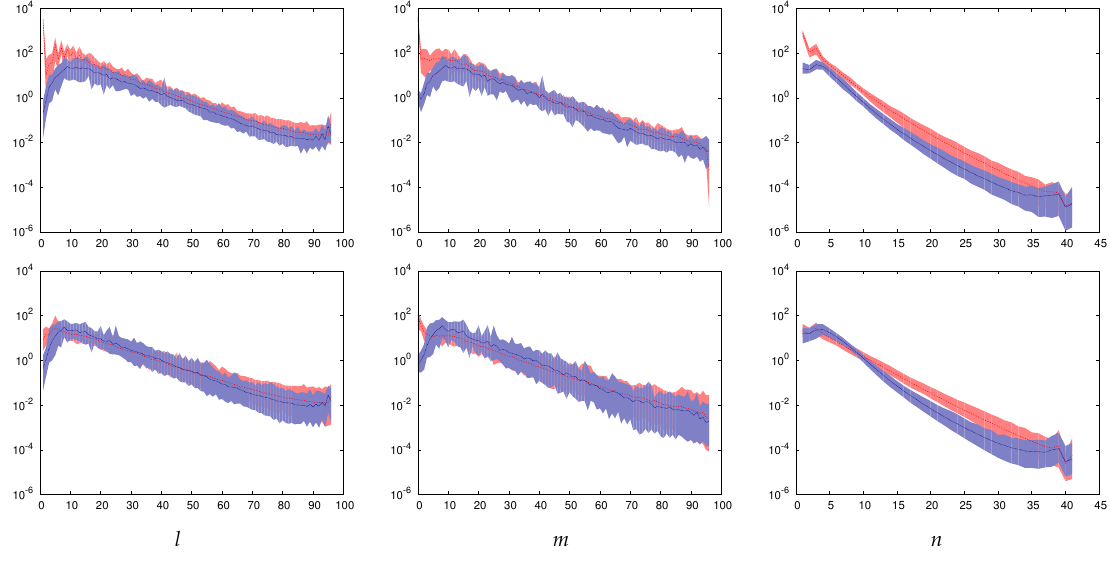
Figure 6. A MD (top row) and a FD (bottom row) dynamo solutions at η = 0.5, R = 8.2 τ = 2 10 4 , P = 0.75 and P m = 1.5 corresponding to the cases shown in Figure 5. The first column × shows meridional lines of constant B ϕ in the left half and of r sin θ∂ θ h = const . in the right half. The second column shows lines of constant B r at r = 1.675 r o . The third column shows meridional lines of constant u ϕ in the left half and of r sin θ∂ θ v in the right half. The fourth column shows contours of the radial flow u r on the equatorial plane. Positive values are shown in red; negative values are shown in blue, and the zeroth contour line is shown in green. (Colour online).